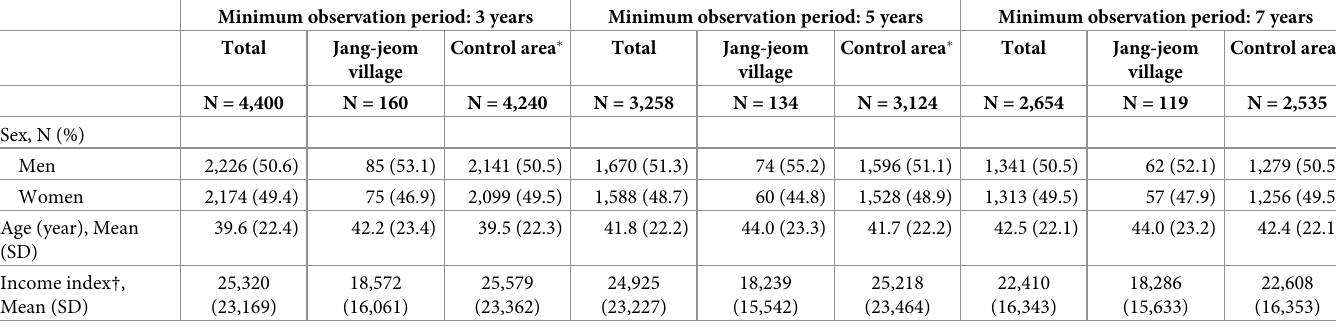
Table 2. Characteristics of retrospective cohort subjects according to minimum observation period. Minimum observation period: 3 years Minimum observation period: 5 years Minimum observation period: 7